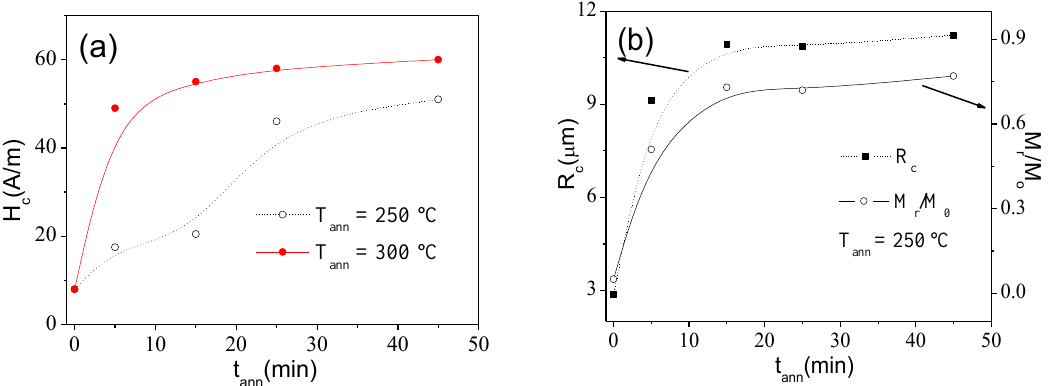
Figure 15. Dependence of coercivity, H c , ( a ) and reduced remanent magnetization, M r / M Hmax ( b ) on annealing time, t ann in Co 69.2 Fe 4.1 B 11.8 Si 13.8 C 1.1 microwires. Adapted from [96] Copyright © 2014 Springer Nature.